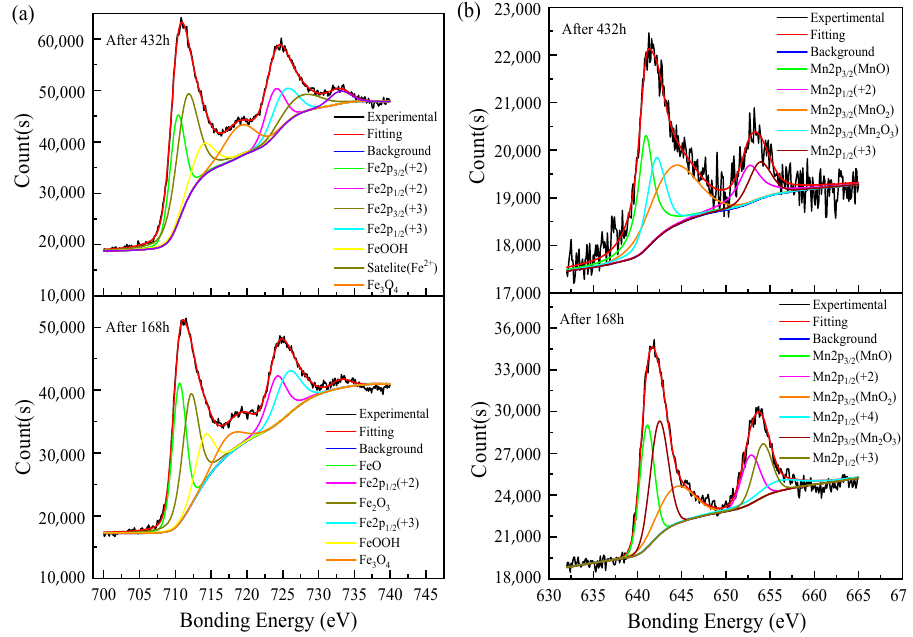
Figure 8. XPS patterns of corrosion products of tested steel after corrosion testing times of 168 h and 432 h: ( a ) Fe2p; ( b ) Mn2p.